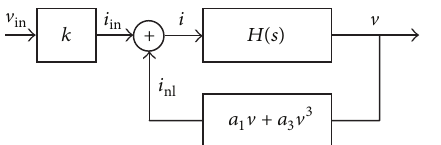
Figure 8: Block diagram of the injection locked frequency divider in Figure 5.